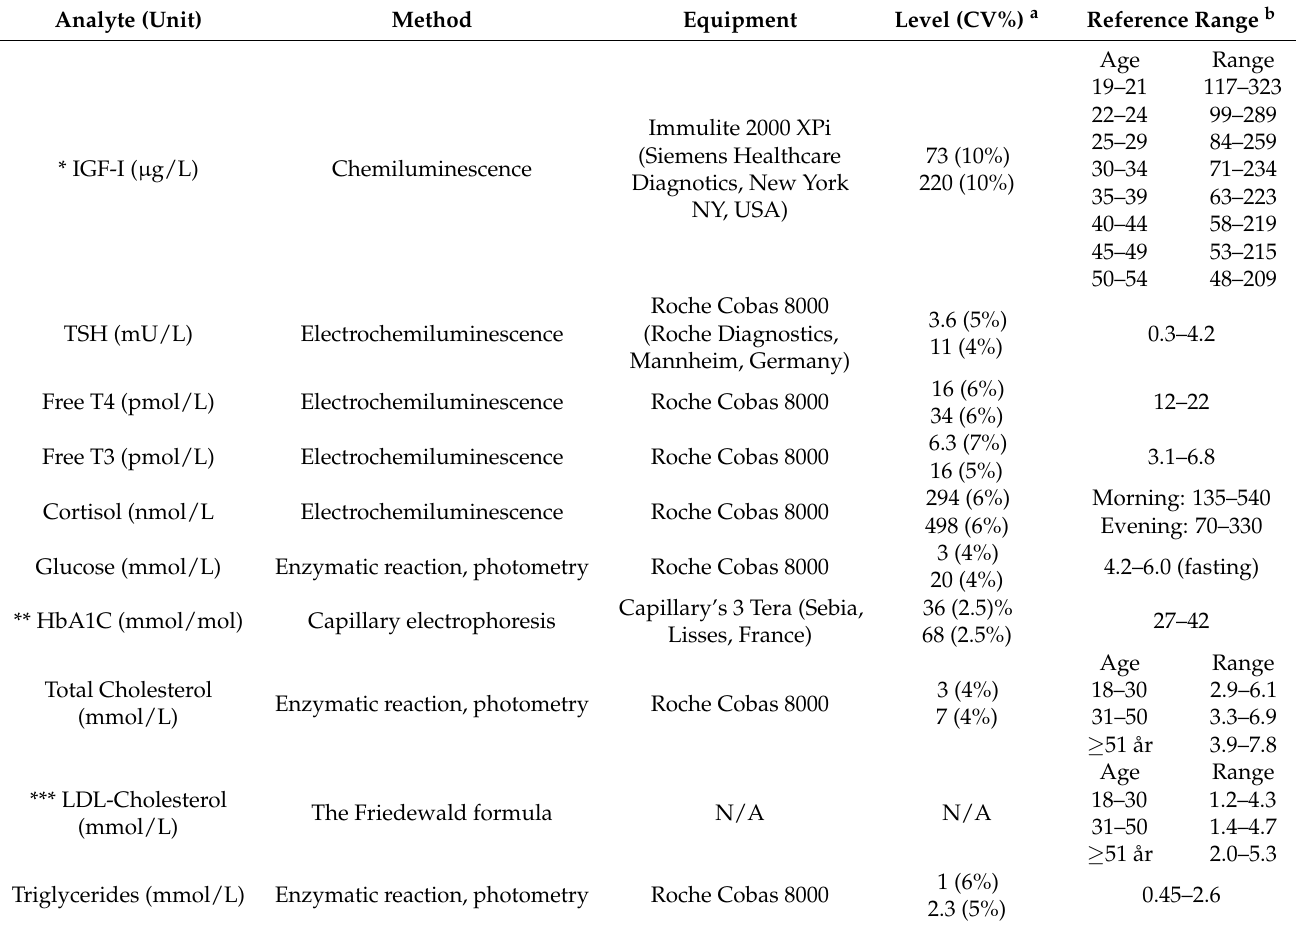
Table 1. Characteristics of laboratory analytes and measurements in Table